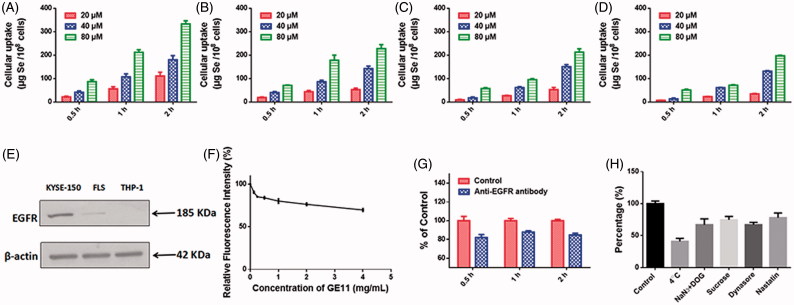
Cellular uptake of GE11-Se NPs. Cellular uptake of (A) coumarin-6-loaded GE11-Se NPs and (B) coumarin-6-loaded Chi-Se NPs in KYSE-150 cells, n = 3. Cellular uptake of coumarin-6-loaded GE11-Se NPs in (C) FLS and (D) THP-1 cells, n = 3. (E) EGFR expression in KYSE-150 cells, fibroblast-like synovial cells and THP-1 cells. (F) Intracellular uptake of coumarin-6-loaded GE11-Se NPs in KYSE-150 cells with free GE11 peptide competition, n = 3. (G) Cellular uptake of coumarin-6-loaded GE11-Se NPs in KYSE-150 cells with anti-EGFR antibody block, n = 3. (H) Cellular uptake of coumarin-6-loaded GE11-Se NPs in KYSE-150 cells under different endocytosis inhibition conditions, n = 3.